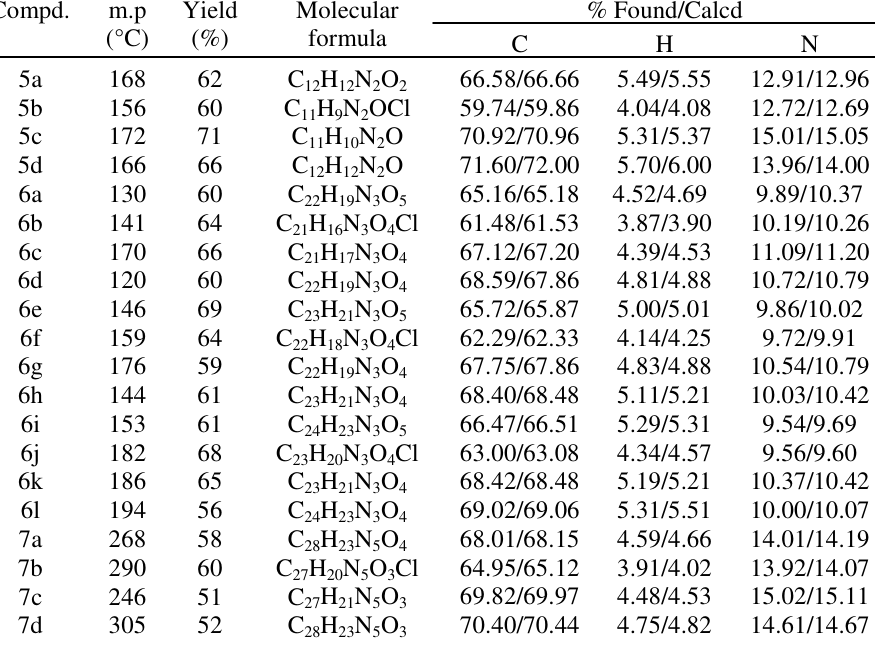
Stand. (Activity index) = Inhibition zone of the sample/Inhibition zone of the standard. Standard used: Amicacin Table-2 . Physical and analytical data of compounds 5a-d, 6a-l and 7a-l.